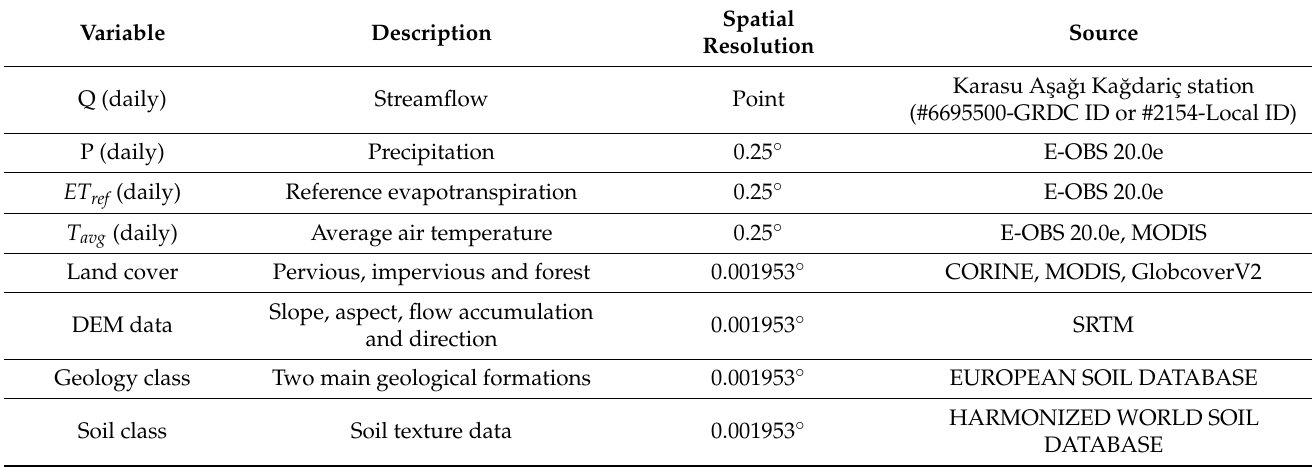
Table 1. Overview of input